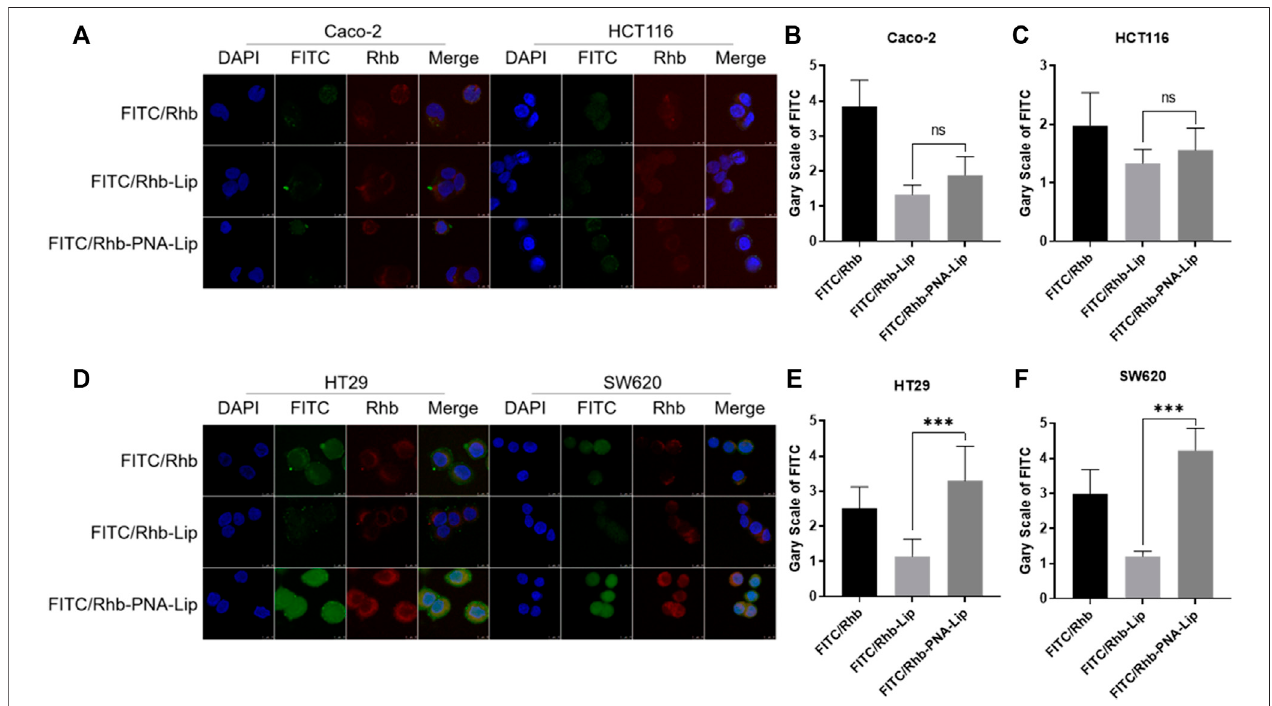
FIGURE 5 | CLSM analysis showed that PNA-modi fi ed liposomes enhance the cellular uptake of drugs by MUC1-positive cells. (A) CLSM observation of the distribution of fl uorescence signals in Caco-2 and HCT116 cells. (B,C) Quantitative histograms of FITC fl uorescence signals in Caco-2 and HCT116 cells. (D) CLSM observation of the distribution of fl uorescence signals in HT29 and SW620 cells. (E,F) Quantitative histograms of FITC fl uorescence signals in HT29 and SW620 cells. The data are presented as the mean ± SD (n = 3). ***p <